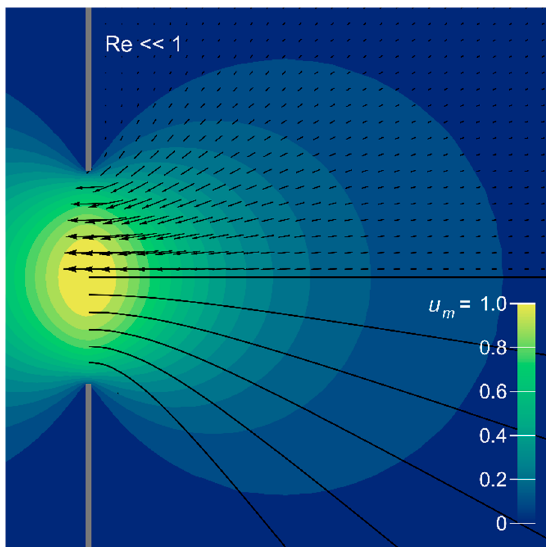
Figure A1. Velocity field of creeping Sampson flow through a circular aperture in a flat plate (indicated schematically by a broken grey line). Magnitudes are represented by color contours, relative to the maximum u m at the center of the aperture, and are symmetric about the flow axis and wall plane. Flow direction is indicated by vectors and streamlines in black.